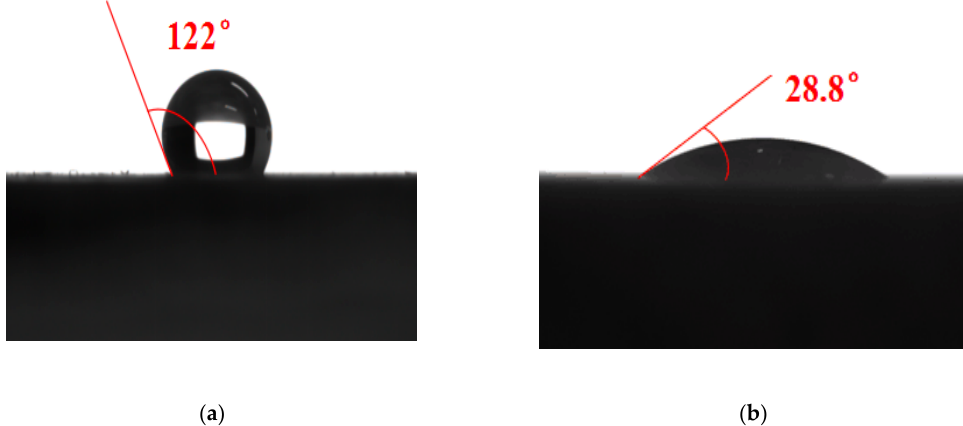
Figure 7. Contact angle of oil droplets on ( a ) water-wet core slice and ( b ) oil-wet core slice.